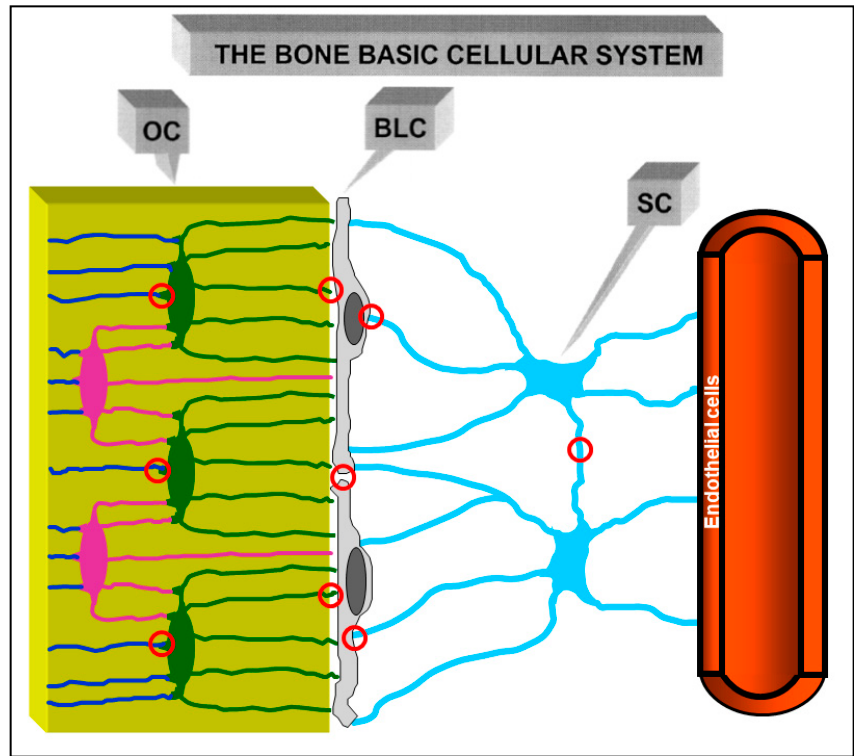
Figure 5. Schematic drawing of the cells of the osteogenic lineage in the resting phase, the Bone Basic Cellular System. From left to right: osteocytes (OC), bone lining cells (BLC), stromal cells (SC) and one vascular capillary. This cell network forms a functional syncytium since cells are joined by gap junctions (red circles).